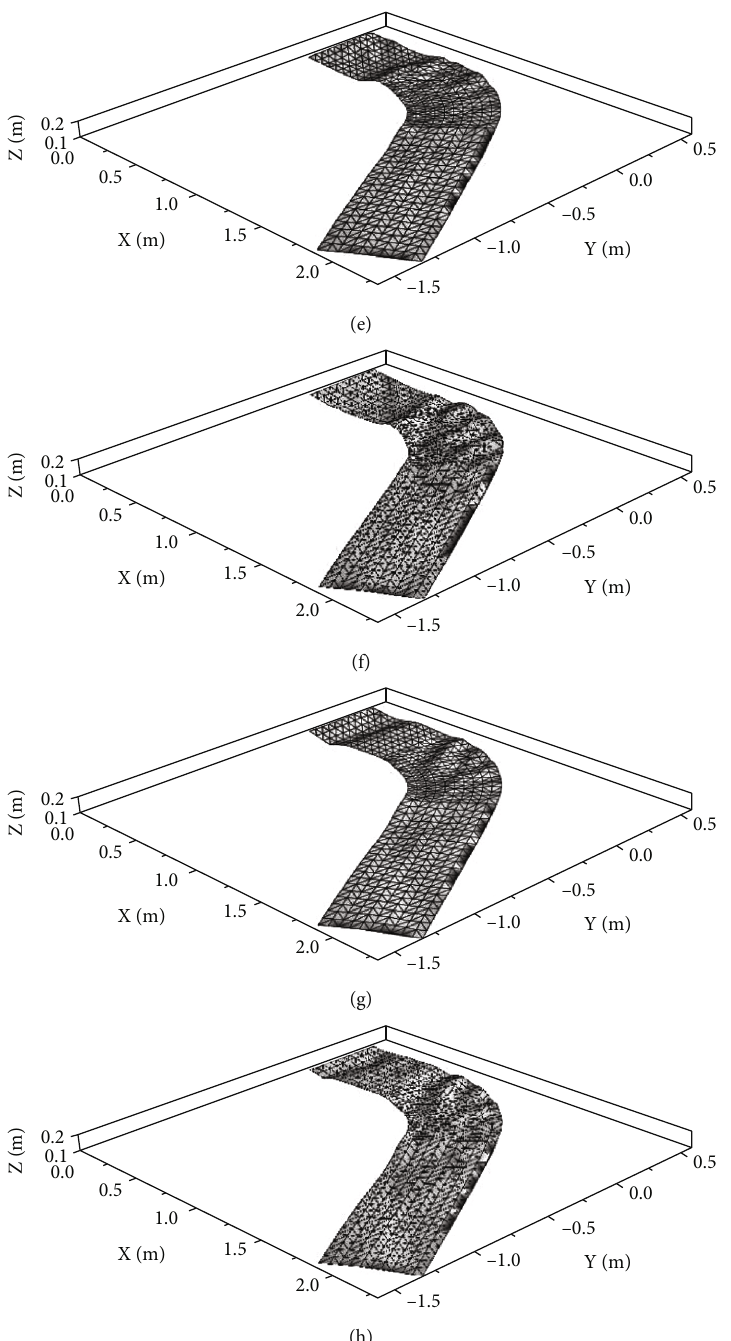
Figure 4: Comparison of the fl ow patterns in the runs with and without R-SEDs in the spillway. (a) Run 0 (without R-SEDs); (b) Run 1; (c) Run 4; (d) Run 7; (e) Run 10; (f) Run 13; (g) Run 16; (h) Run